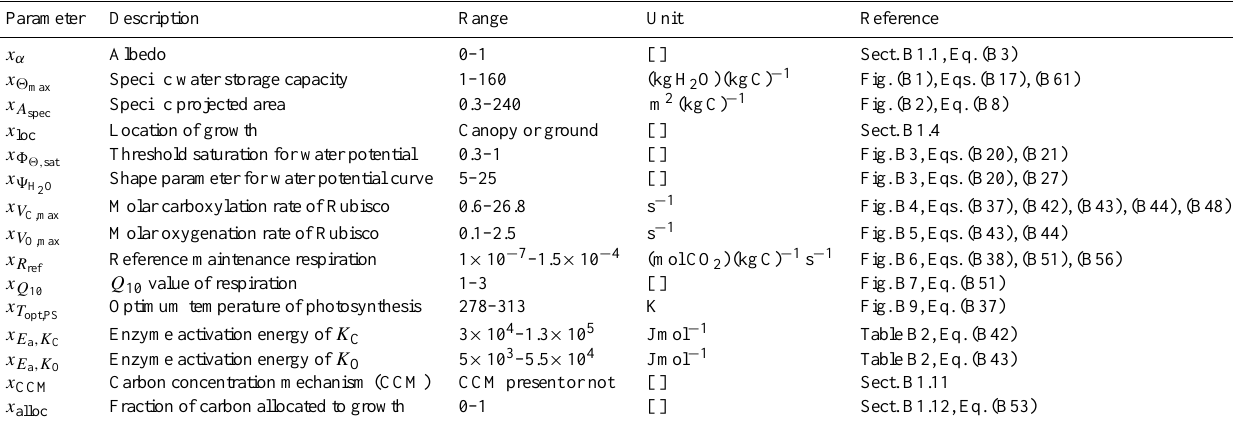
Table B9. Overview of lichen or bryophyte random parameters used in the model.